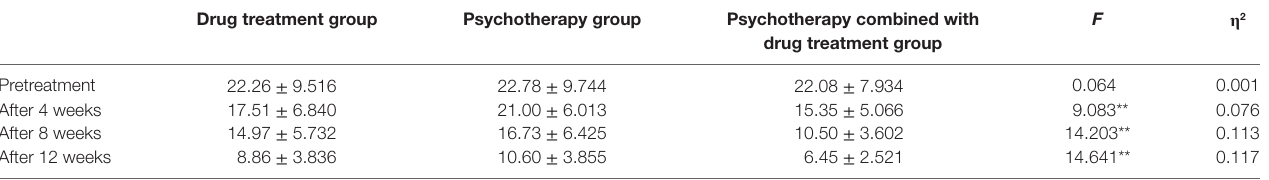
TaBle 3 | Comparison of symptom scores before and after treatment of patients in each group. Drug treatment group